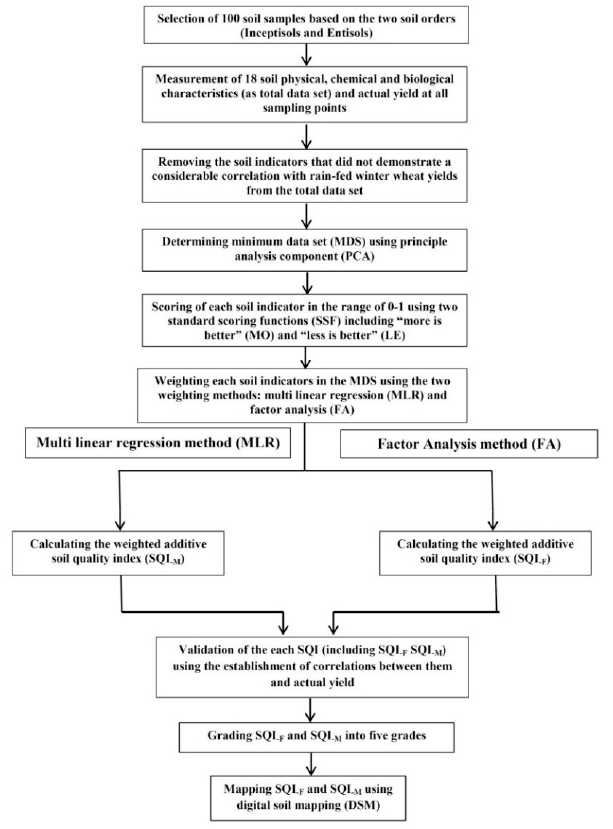
Figure 2. Flowchart of methodology used in this study.